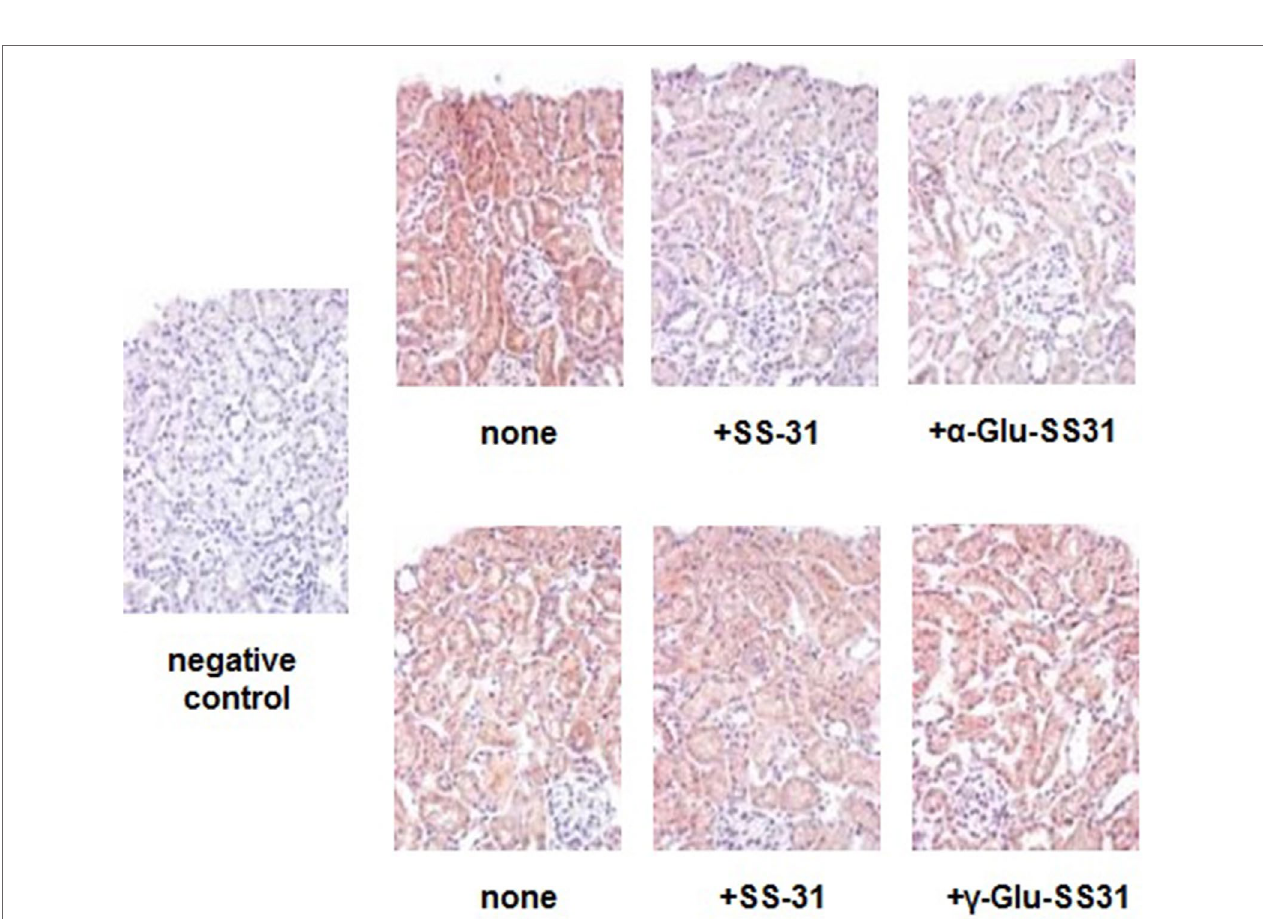
FIGURE 7 | Selective inhibition of the enzymatic activities of aminopeptidase A and γ -glutamyltranspeptidase by SS-31, α -Glu-SS-31 or γ -Glu-SS-31 determined by histoenzymography in the kidneys of mice exposed to adriamycin. Sequential sections (7 µm) of frozen OCT-embedded kidneys of adriamycin (ADR)-treated mice were exposed at 37°C to β -methoxynaphthylamide ( β -NA) specific substrates of aminopeptidase A ( α -Glu- β NA, upper panels) or γ -glutamyltranspeptidase ( γ -Glu- β NA, lower panels) and Fast Blue B, in the absence (none) or the presence of SS-31, α -Glu-SS-31 or γ -Glu-SS-31. The sections were then counterstained with light hematoxylin reagent. The enzymatic activity is visualized as a red precipitate. For the negative control, we used Fast Blue B in the absence of β -NA substrate. Representative renal cortical sections per experimental groups are shown (200x